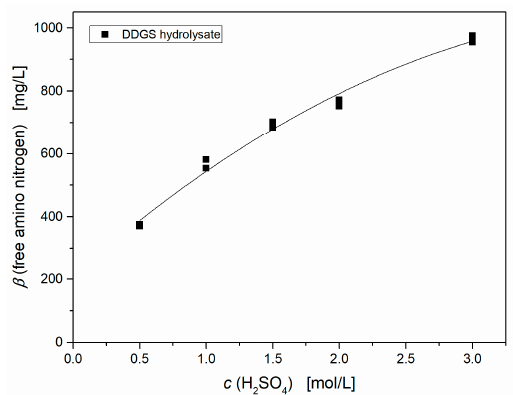
Figure 3. Correlation between sulfuric acid concentration and free amino nitrogen amount after chemical hydrolysis of DDGS.